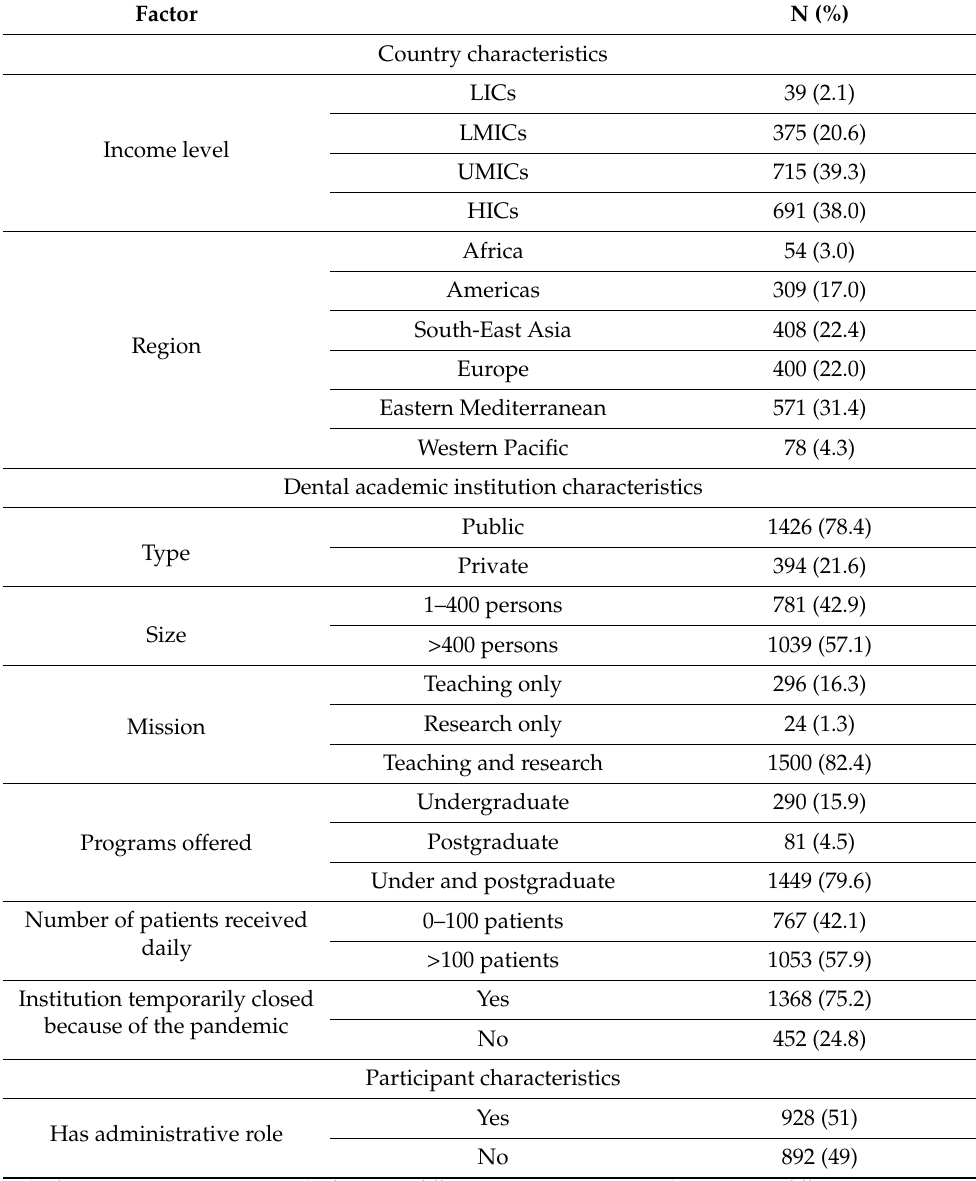
Table 1. Characteristics of countries, academic institutions, and participants included in the study (n =